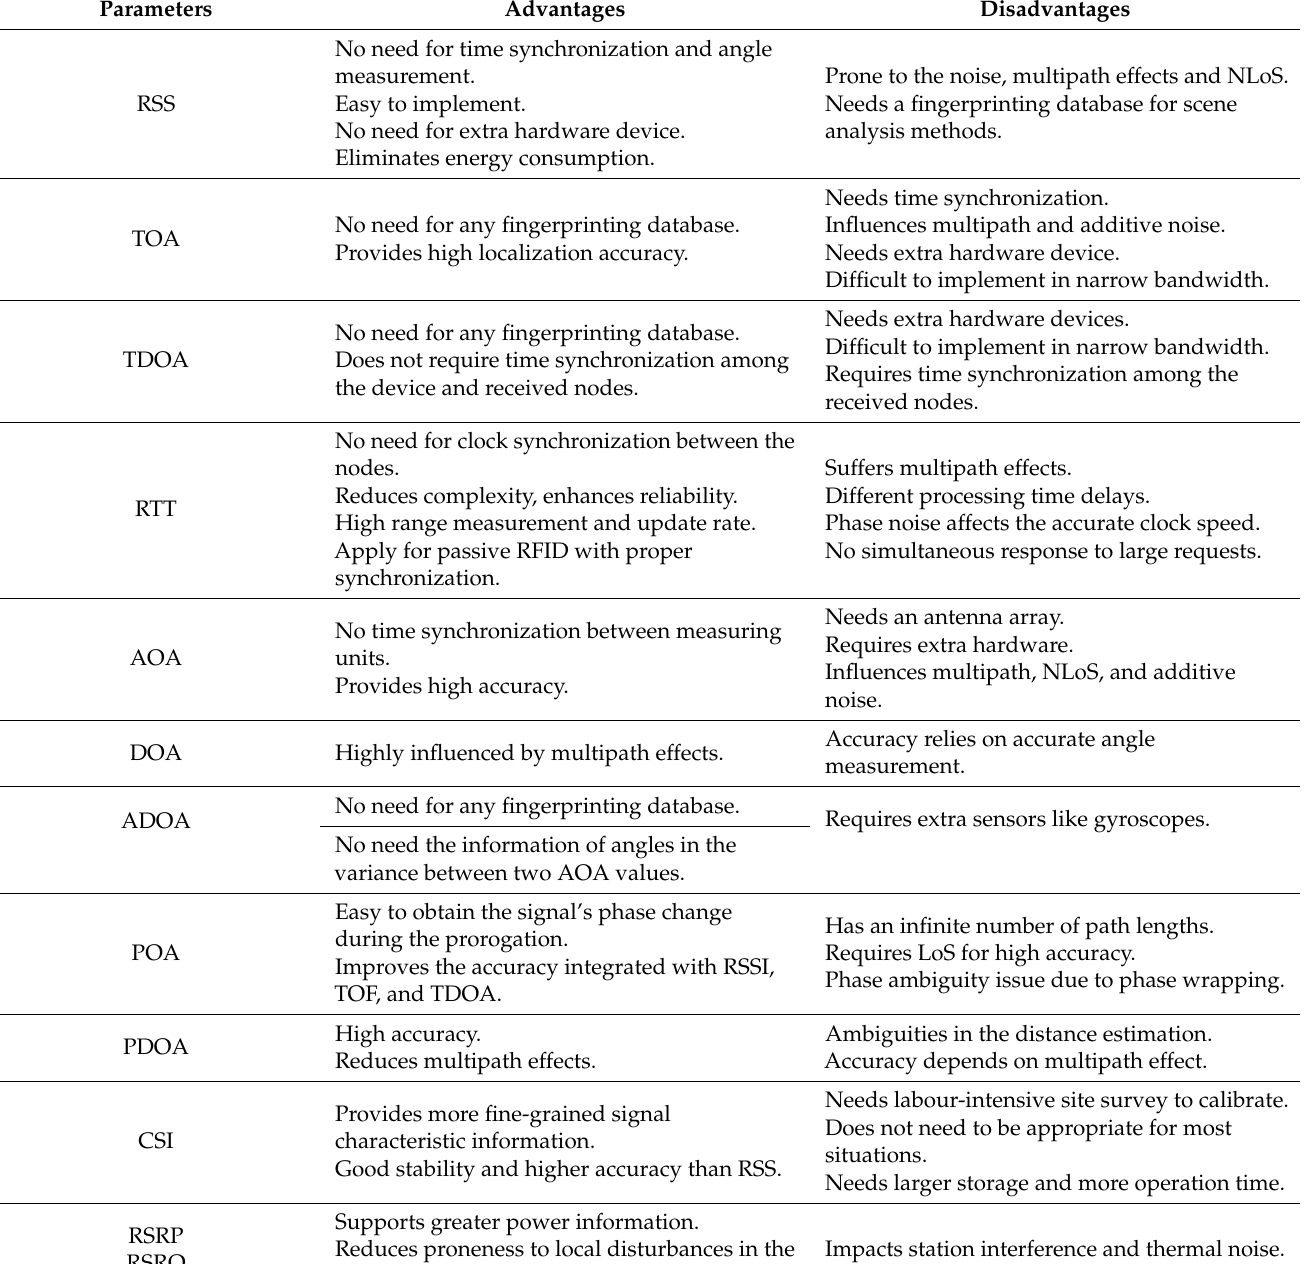
Table 1. Summary of the different localization measurement